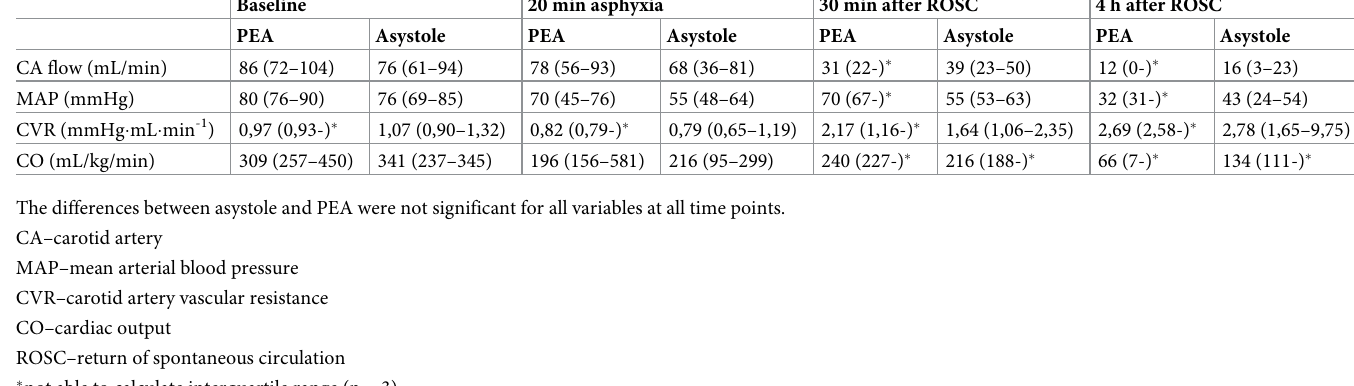
Table 2. Hemodynamic variables in piglets with pulseless electrical activity (PEA) versus asystole reported as median (interquartile range). Baseline 20 min asphyxia 30 min after ROSC 4 h after ROSC PEA Asystole PEA Asystole PEA